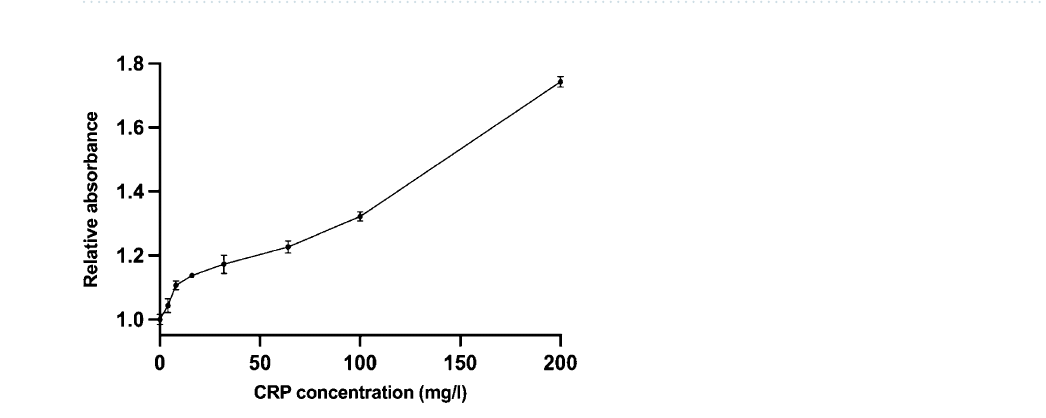
Figure 4. The CRP measurements with reporter luminescence. The relative luminescence is decreasing as a function of CRP concentration. Error bars are the coefficients of variance % of the signals from three replicate measurements.